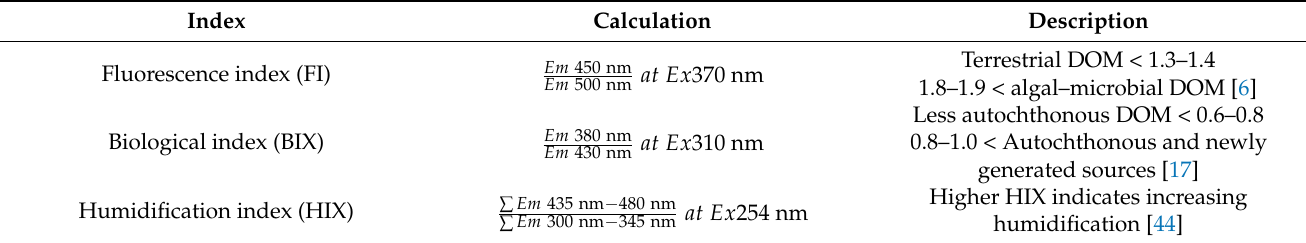
Figure 5. Comparison of fluorescence and spectroscopic indices (FI, HIX, BIX, SUVA 254 , and Slope 275–295 ) for the six major tributaries of the Miho stream watershed. Table 3. Description of fluorescence index